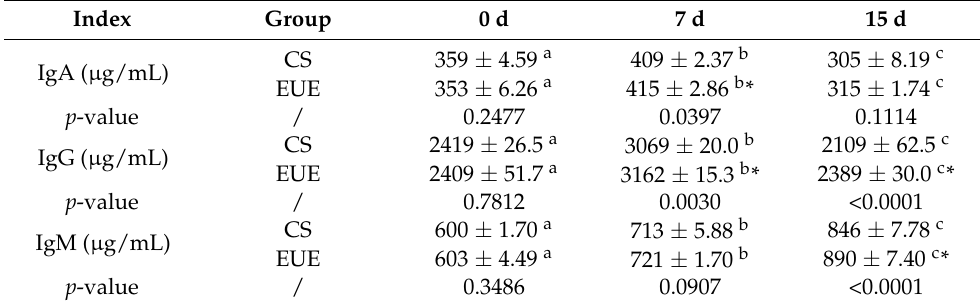
Table 7. The immune parameter status of chicks under cold stress.